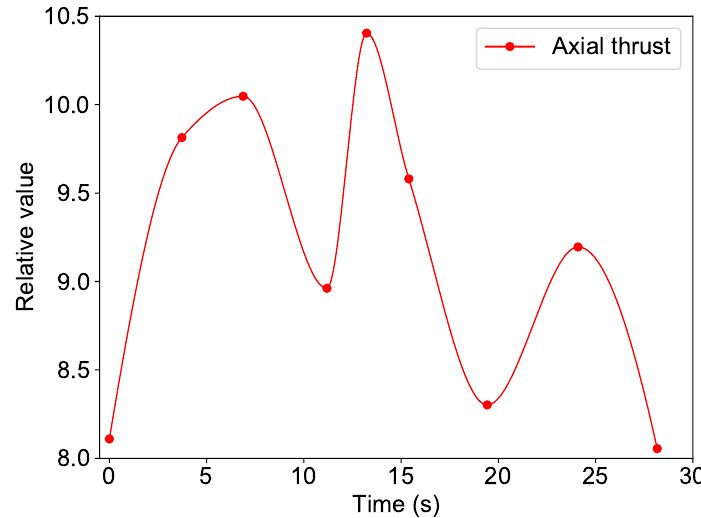
Figure 16. Axial thrust of the head cover during load rejection.